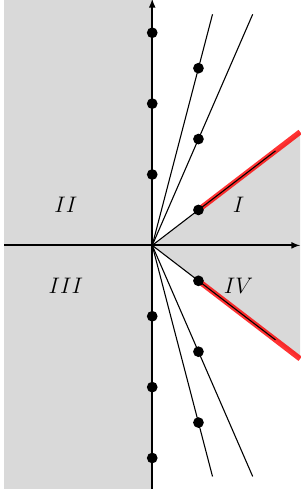
( g ) , ϕ ( g ) in s s 0;2 1;2